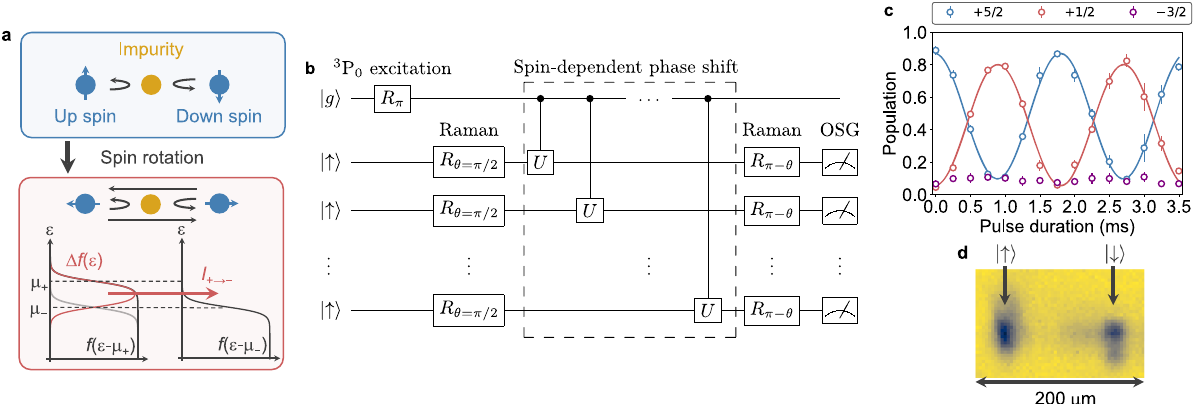
Fig. 1 Schematic illustration of the experiment. a Schematic representation of spin-space quantum transport. By spin rotation, quantum transport is induced in spin space. Black lines show the Fermi-Dirac distribution function, and a red line shows the differential distribution function Δ f ( ε ) = f ( ε − μ + ) − f ( ε − μ − ). b Quantum-circuit representation of a typical experimental sequence. The 3 P 0 excitation ( R π ) transfers the g j i m F ¼ (cid:2) 5 = 2 in the circuit for simplicity, the multiple impurity scattering should occur in experiments. c Raman Rabi oscillation between the " show the standard deviations of the mean values obtained by averaging three measurements. Solid lines represent fi ts to the data. d Typical example of simultaneous observation of both spin states in false color time-of- fl ight (ToF) image of the two-component 173 Yb gas subjected to the OSG light. The distorted (cid:1) (cid:3) (cid:1) shape of the atom cloud in the # state is ascribed to the photon scattering by the OSG